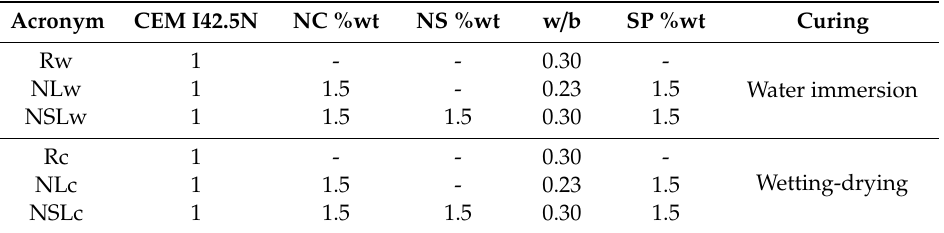
Table 3. Composition of cement